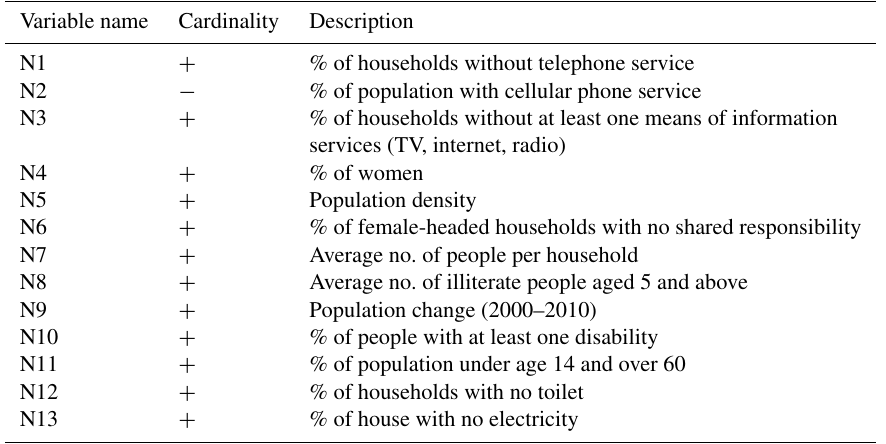
Table 1. Variables used in SoVI analysis.